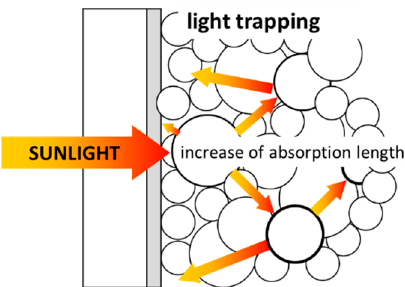
Figure 2. Schematic of the light trapping phenomenon in the nanostructured DSSC photoanode.